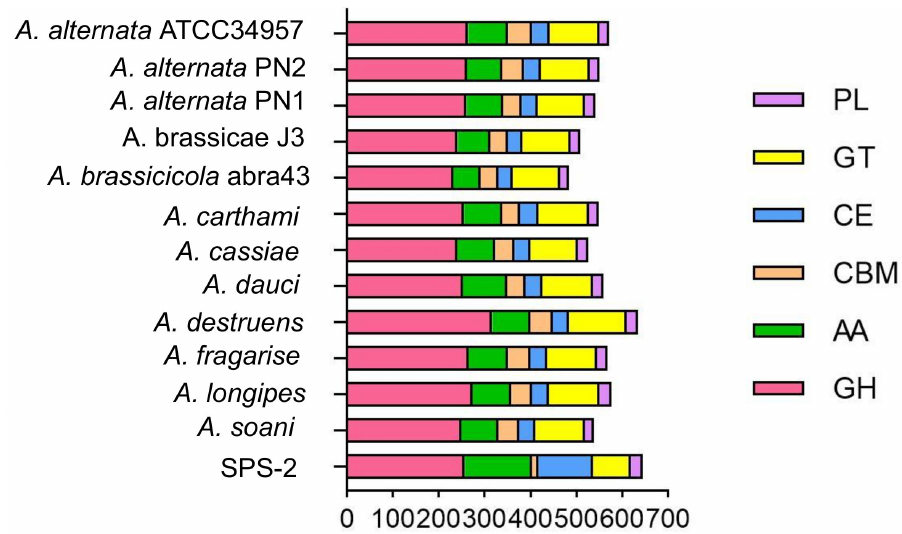
Figure 4. CAZyme family members of strain SPS-2 and other Alternaria strains deposited in the CAZy database.